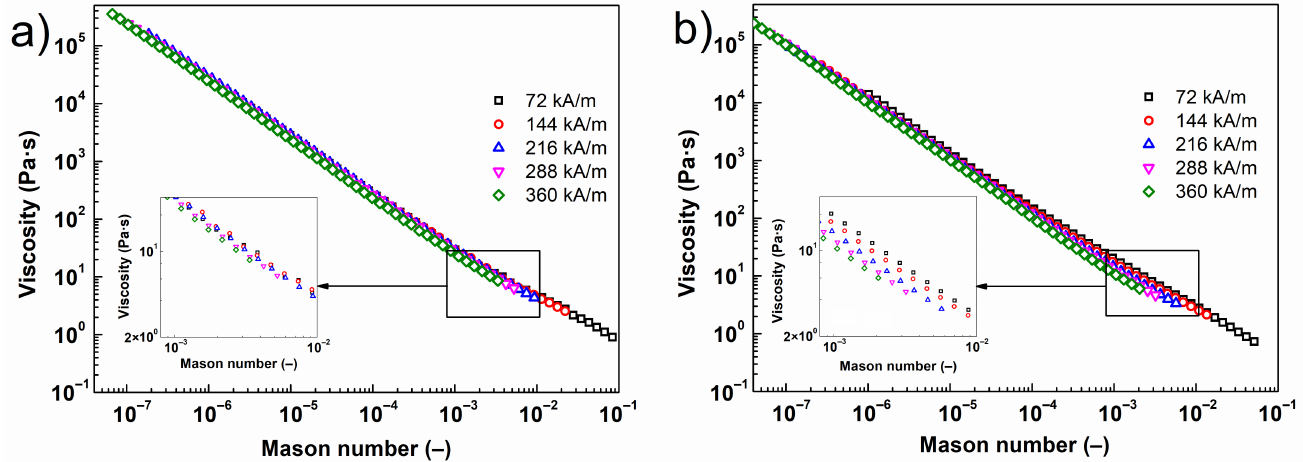
Figure 8. Shear viscosity as a function of Mason number for the reference MR fluid ( a ) and its bidisperse analogues supplemented with NPs@TEOS ( b ) under various strengths of magnetic